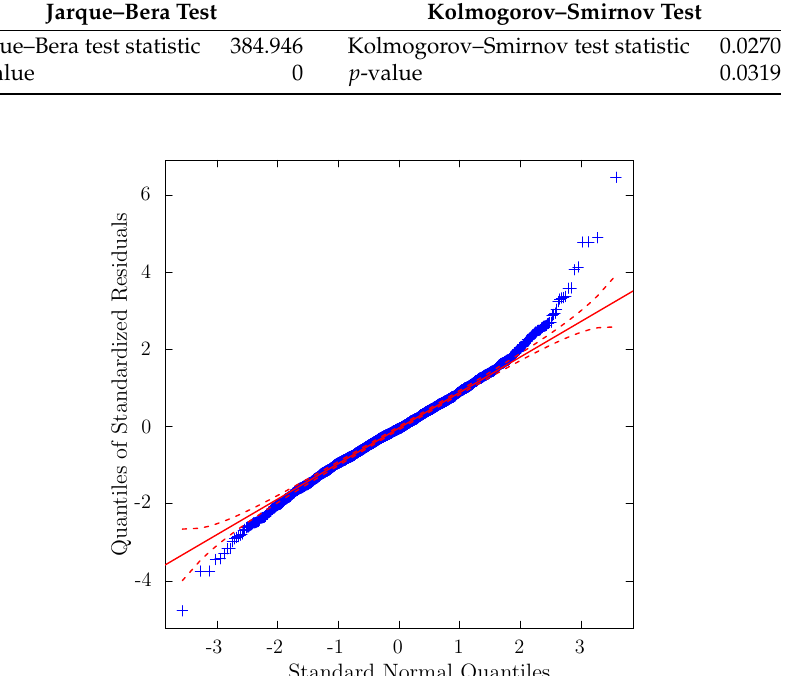
Figure A5. Quantile–quantile plot for standardized